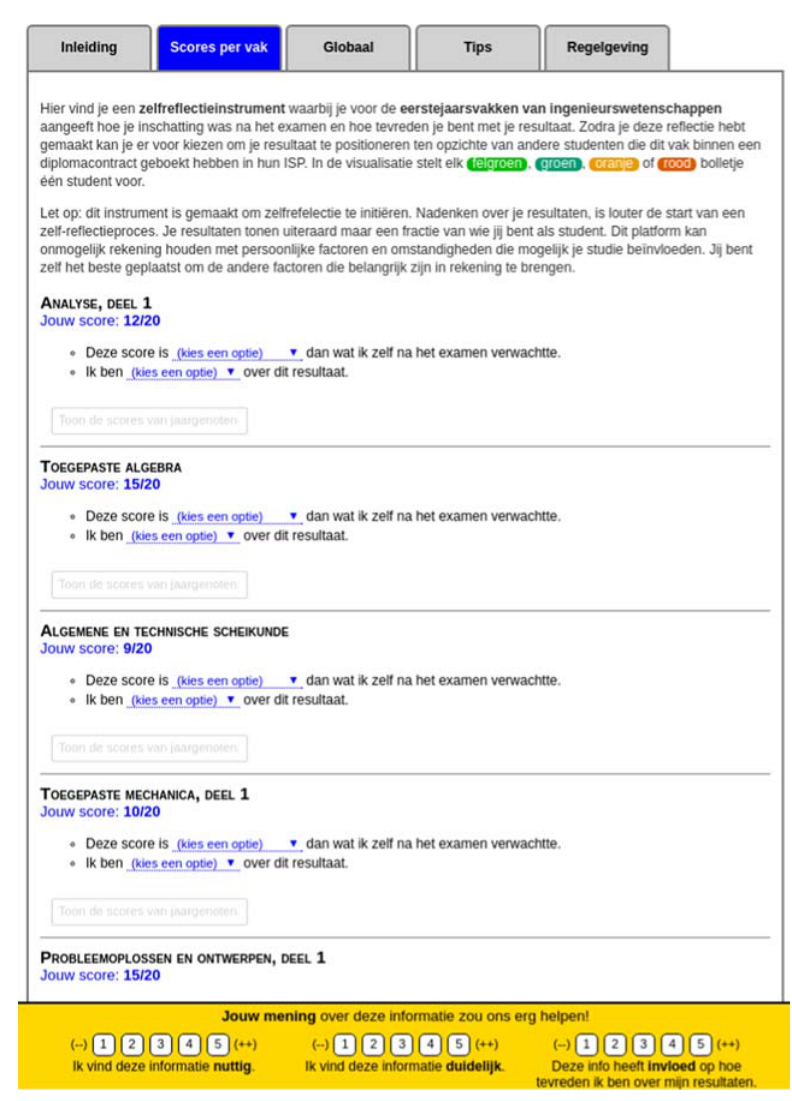
Figure 1. Initial view of the “ Scores per course